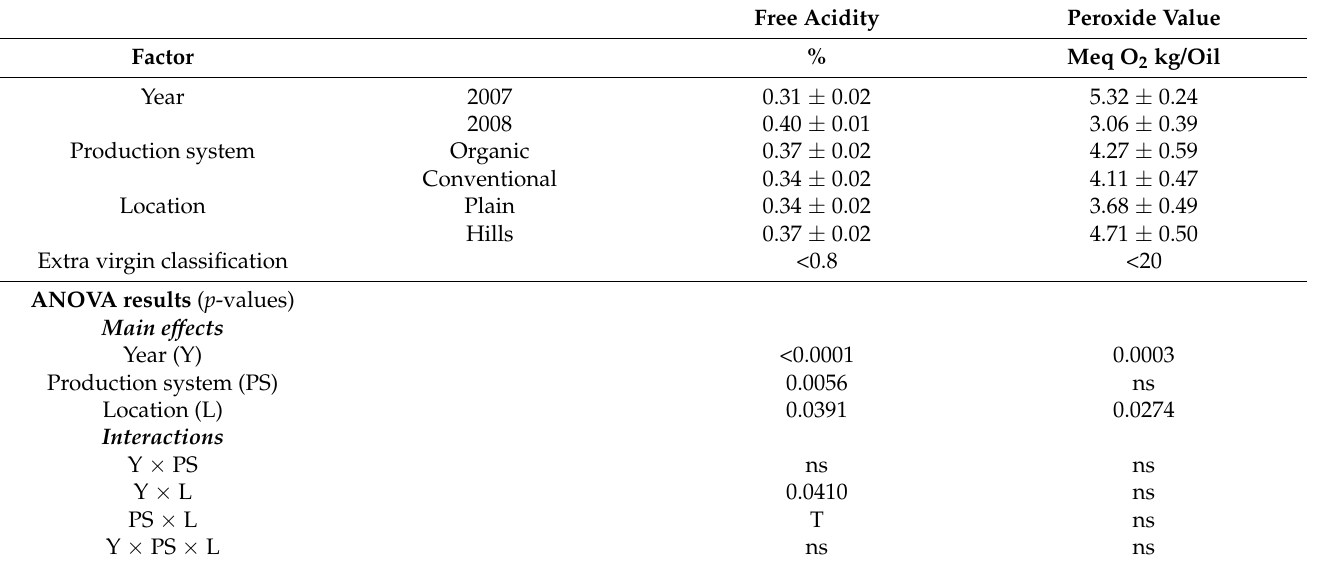
Table 4. Effect of, and interaction between, harvest year (2007, 2008), production system (organic versus conventional) and location of fields (plain versus foot hills) on selected olive oil quality parameters (free acidity, peroxide